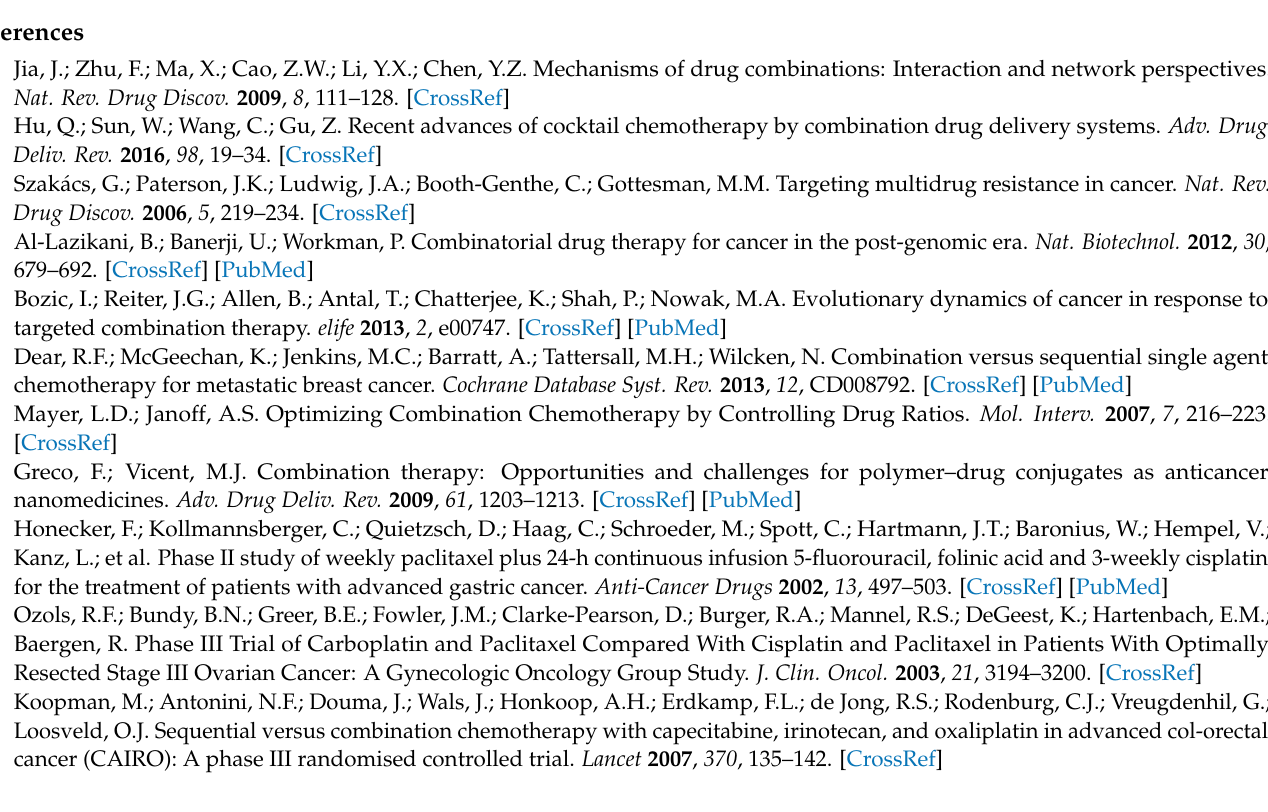
Figure S5: cell viability of HeLa and A549 cells measured after 72 h of a simultaneous treatment with CQ and CDDP either free or encapsulated in HDLDBC-bMPA, Figure S6: alterations to the cell cycle and induction of apoptosis determined by flow cytometry after pre-treatment of HeLa and A549 cells for 18 h with 40 µ M of free CQ or CQ encapsulated in